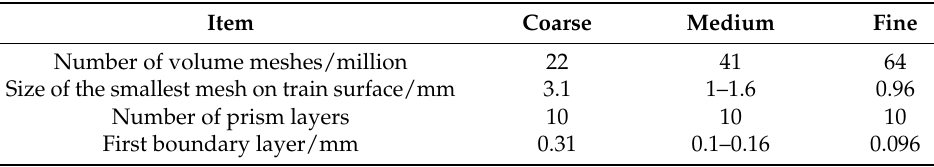
Table 1. Details of the different grid